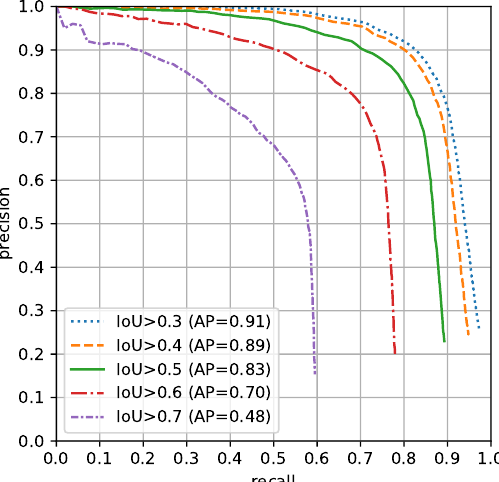
Figure 4. Precision-recall curves of the average SCN-OD network regarding individual tree detection for different intersection of union thresholds.